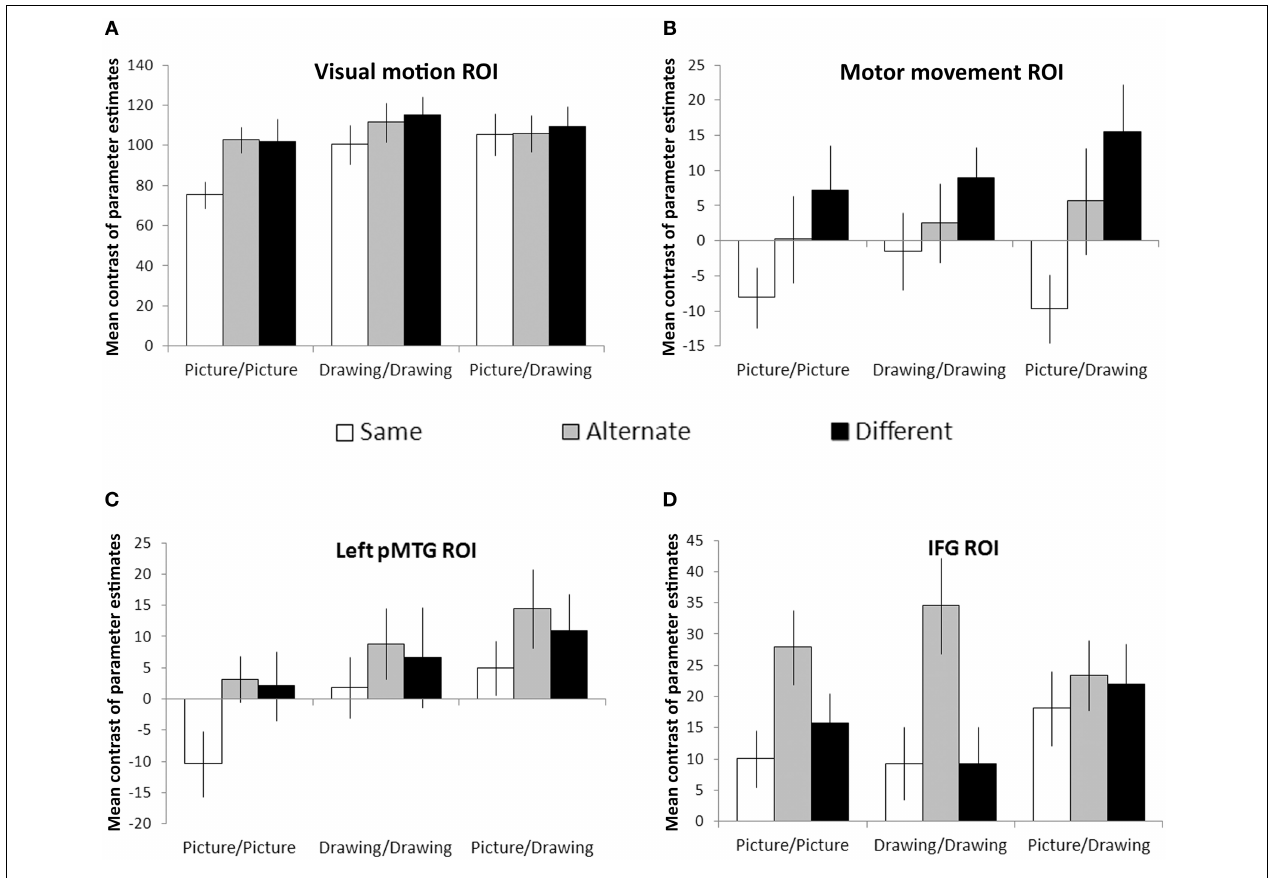
FIGURE 4 | Region-of-interest analyses. Visual motion (A) and motor movement (B) areas were functionally-localized in each participant. Left pMTG (C) and bilateral IFG (D) were defined anatomically using the